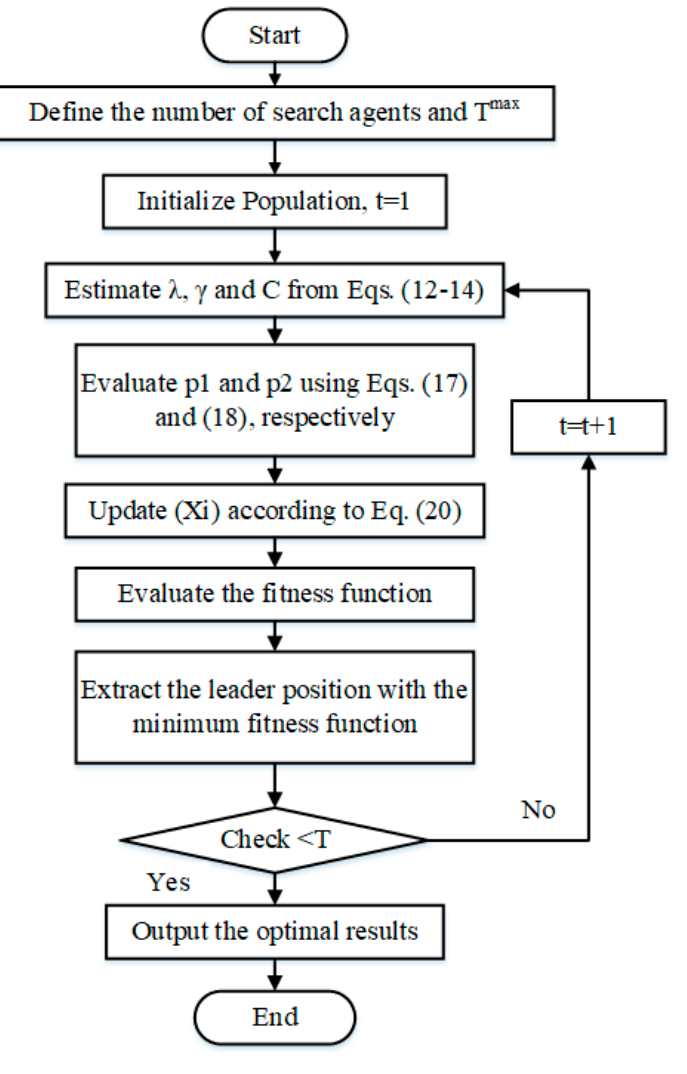
Figure 2. Flowchart of the HBA.